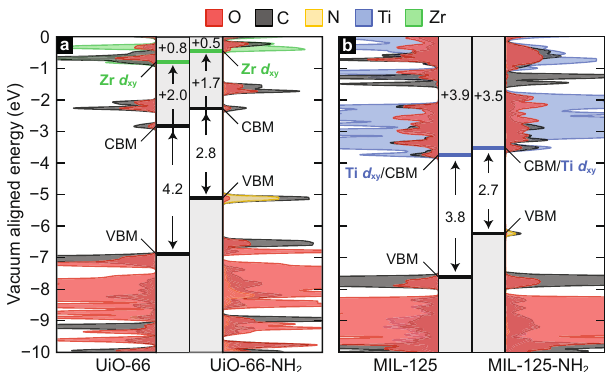
Fig. 5 A comparison of the electronic density of state in Ti-MIL-125 and Zr-UiO-66, and their aminated derivatives. Conduction band engineering d 0 -MOFs using linker amination. a The density of states of reveals UiO-66 is type I with a VBM and CBM de fi ned by organic orbitals. The Zr d xy orbitals are 2.0 eV positive of the CBM in non-functionalized UiO-66, sitting at ~ − 0.75 eV. Amination moves the Zr orbitals 250 meV more positive. b MIL-125 is type IV with a VBM and CBM de fi ned by linker and metal orbitals, respectively. The Ti d xy orbitals shift 100 meV more positive with amination. In both cases, the aminated MOF features a reduced band gap by >1.0 eV. In the UiO-66 series, the ligand-to-metal transition (VBM- to-green band) shifts from 6.2 to 4.5 eV upon the addition of – NH 2 . The workfunctions are computed by summing the vertical values provided for each